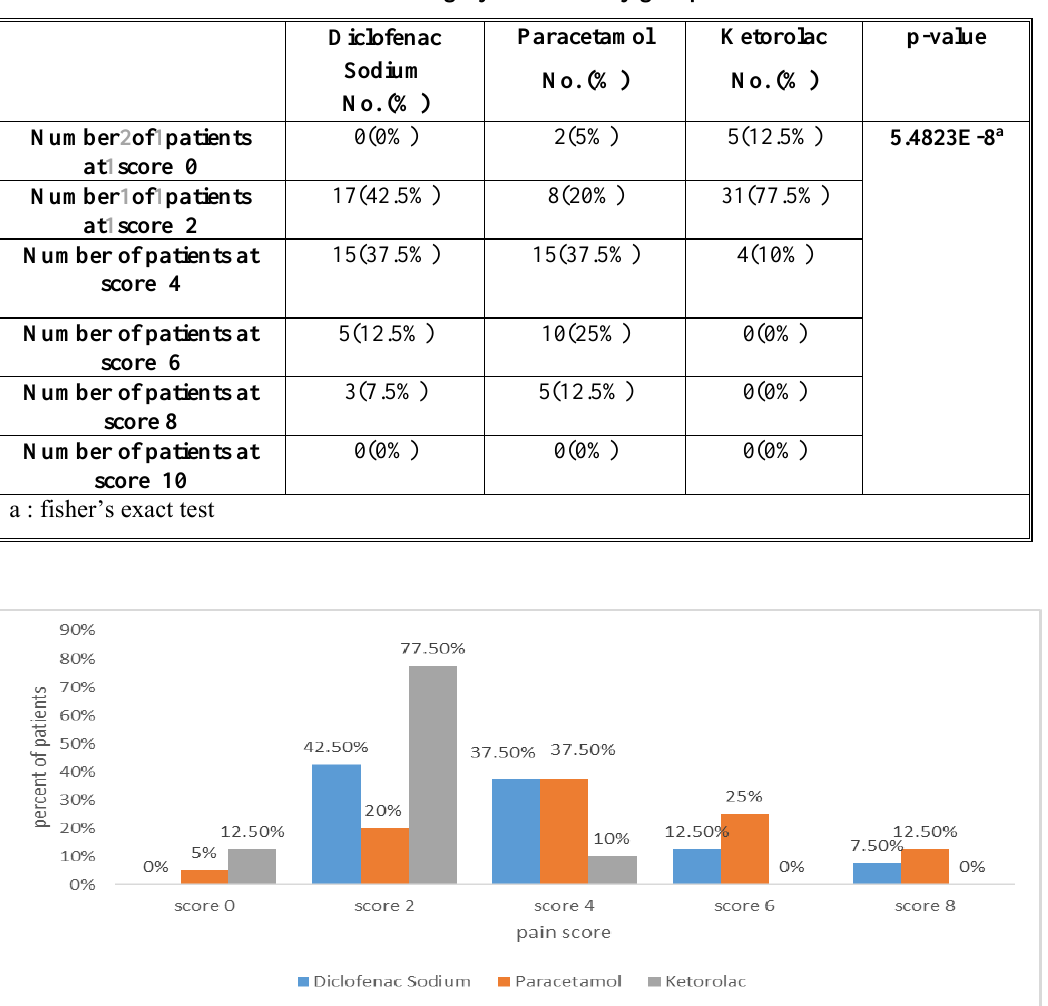
Table 2. Pain score after 30 minutes of surgery for the study groups.